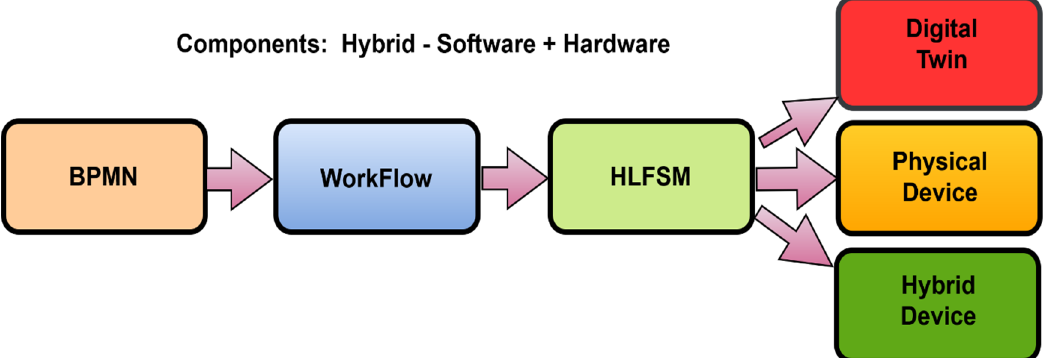
Figure 6. The scheme of the proposal for the IIoT device. Simultaneously, the creation of one comprehensive BPMN diagram to describe